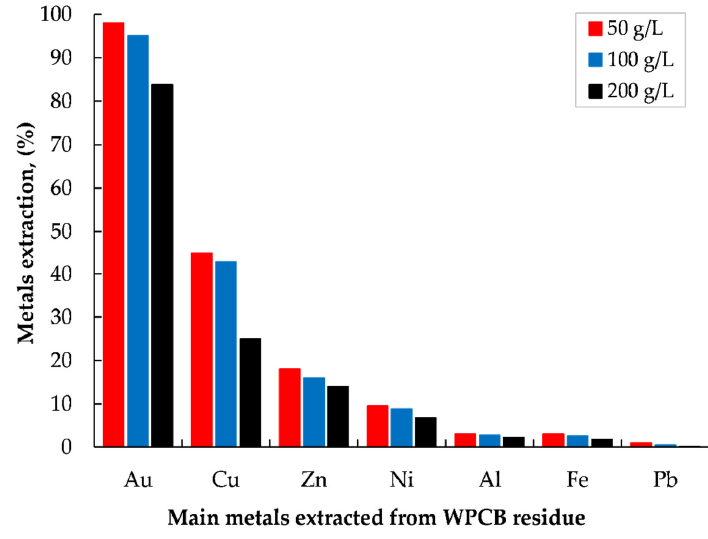
Figure 8. The percentage extraction of metals as a function of pulp density.